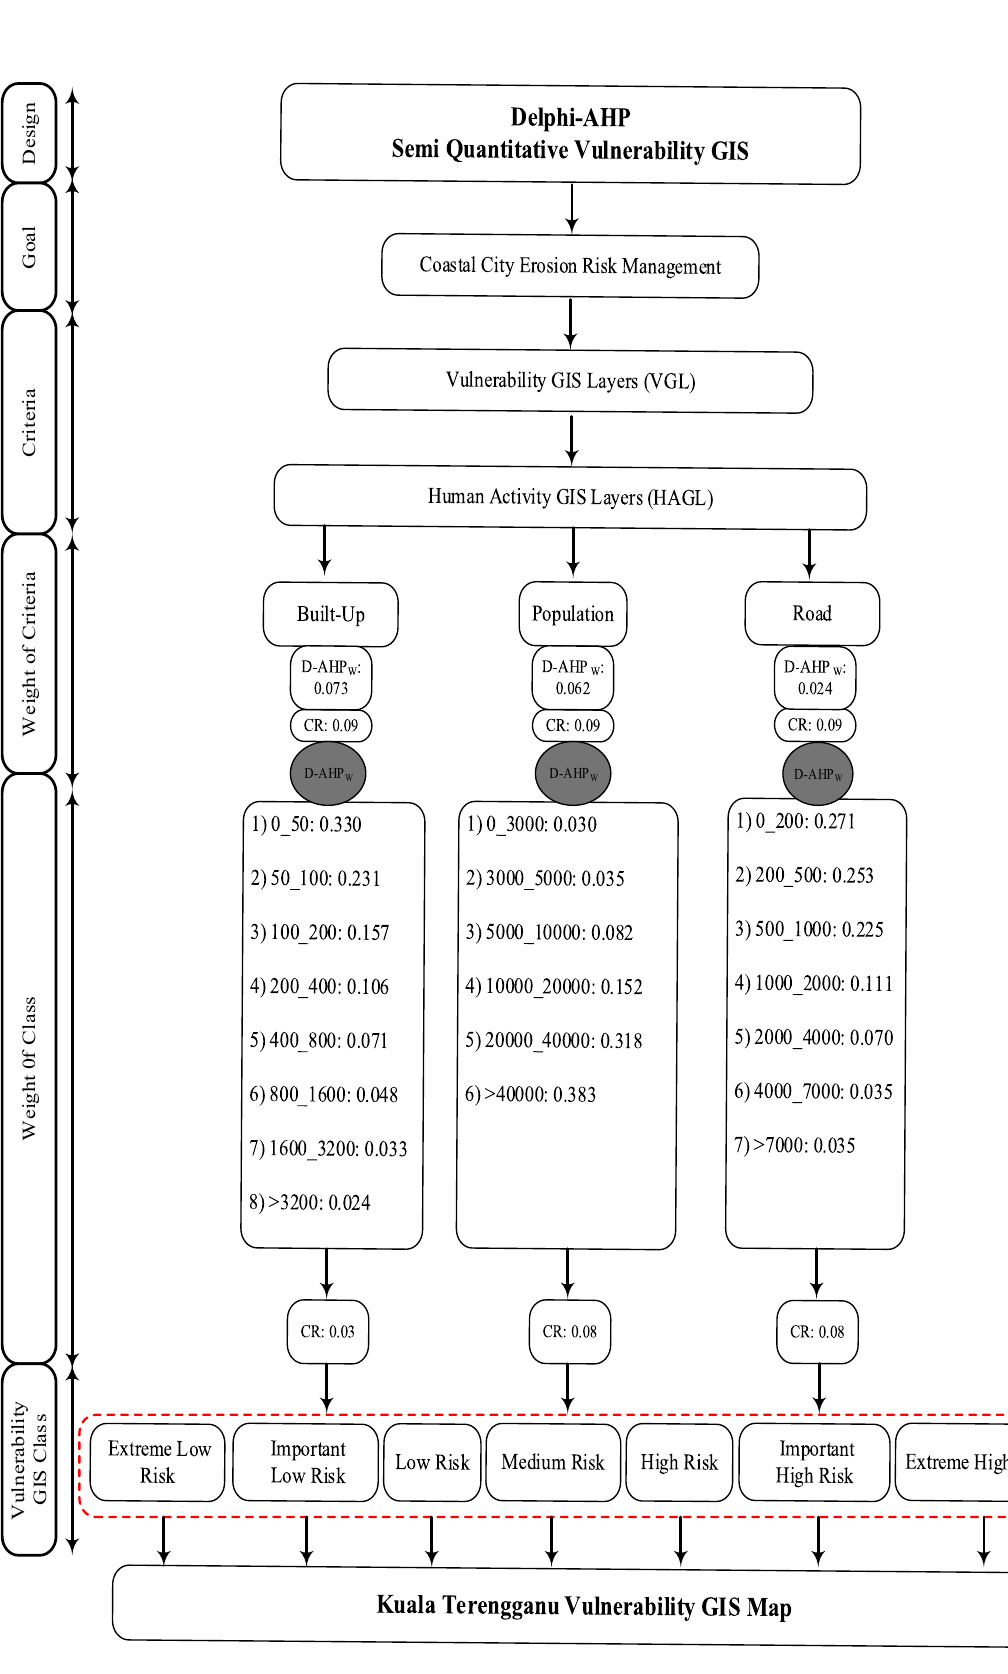
Figure 5. Delphi-AHP design and weights for HAGL.